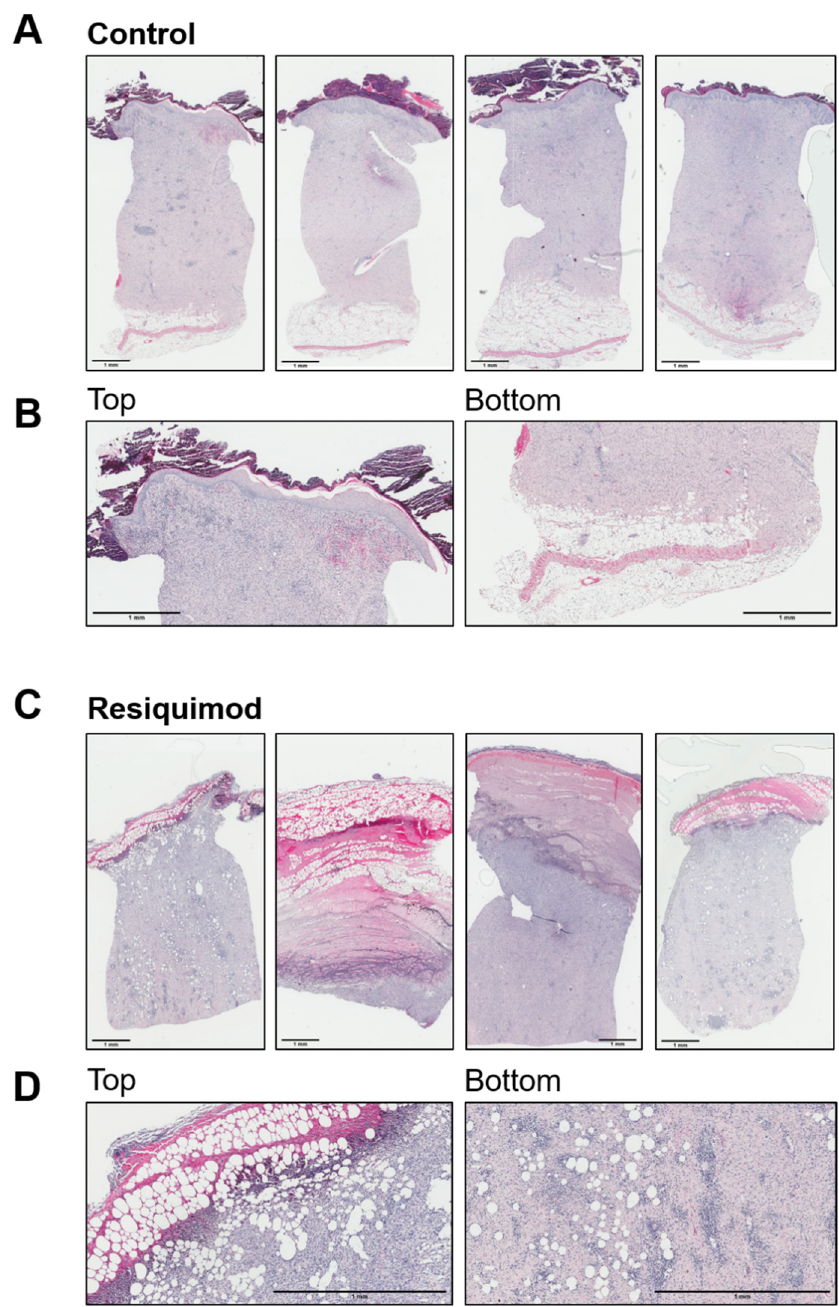
Figure 5. Resiquimod-induced inflammation leads to increased immune cell infiltration. ( A ) Four representative full overviews of haematoxylin/eosin staining of control wounds. ( B ) Detailed overview of one representative picture (left-top of the section); stratum corneum, epidermis and dermis of control wounds (right-bottom of the section) and dermis and subcutaneous adipose tissue of control wounds. Control wounds show physiological layers of skin, including a scab on top of the epidermis and a physiological layer of subcutaneous adipose tissue. ( C ) Four representative full overviews of haematoxylin/eosin staining of resiquimod-induced wounds. ( D ) Detailed overview of one representative picture (left-top of the section) of a barely existing stratum corneum, fully altered epidermis and dermis of resiquimod-induced wounds and (right-bottom of the section) a dermis with dispersed adipocytes in resiquimod-induced wounds. Resiquimod-induced wounds show high immune cell infiltration and no visible skin layers except the dermis. Scale bar = 1